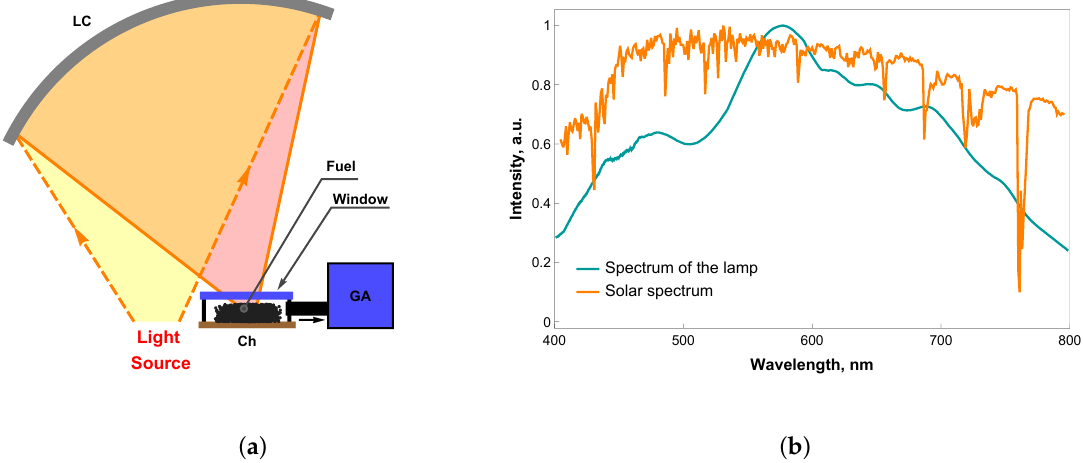
Figure 1. Scheme of the experimental setup ( a ) and the normalized emission spectrum of the lamp vs. the standard solar spectrum ASTM G173-03 ( b ). (a) presents a chamber (Ch) with a fuel, a gas analyzer (GA), and a light concentrating mirror